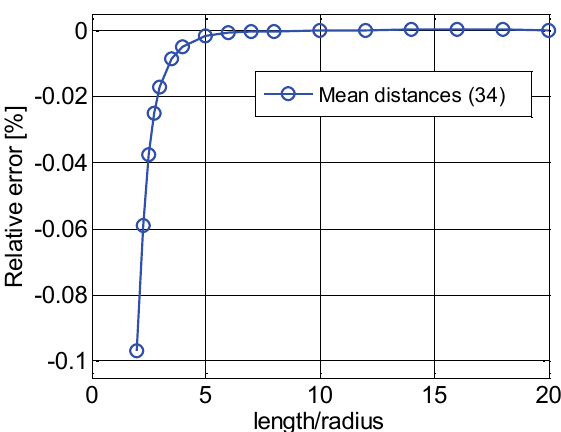
Figure 6: Relative error of formula (34) derived with the mean distances method.